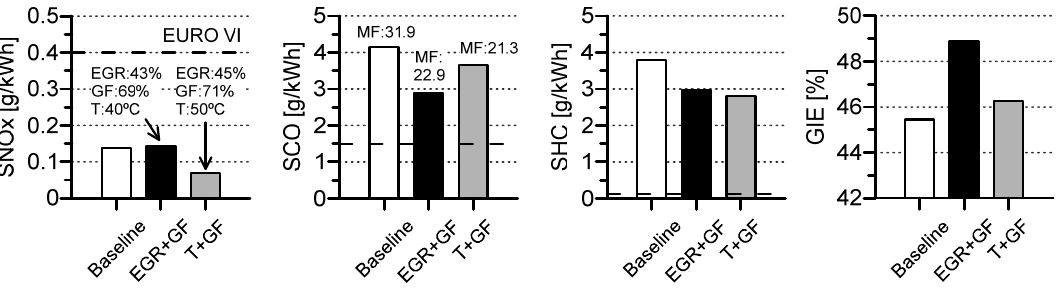
Figure 4. Comparison of the emissions and efficiency obtained with the two strategies versus the baseline condition at 7.5 bar IMEP and 1200 rpm. The merit function values for each case are shown in the second subplot.